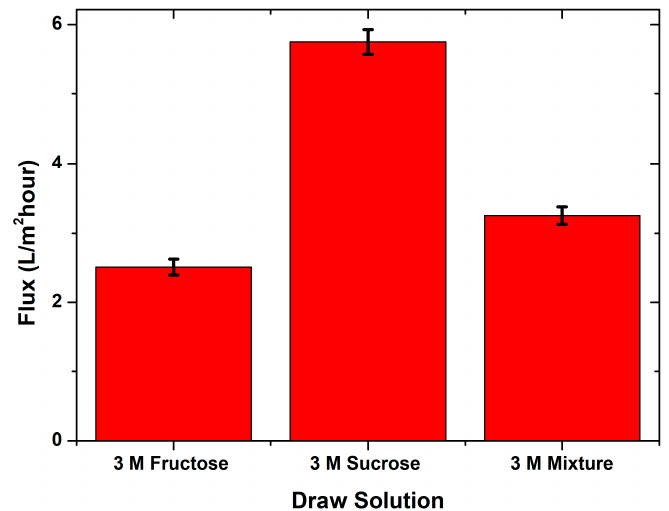
Figure 3. The water flux produced during the FO process brackish water as an FS with different DSs.